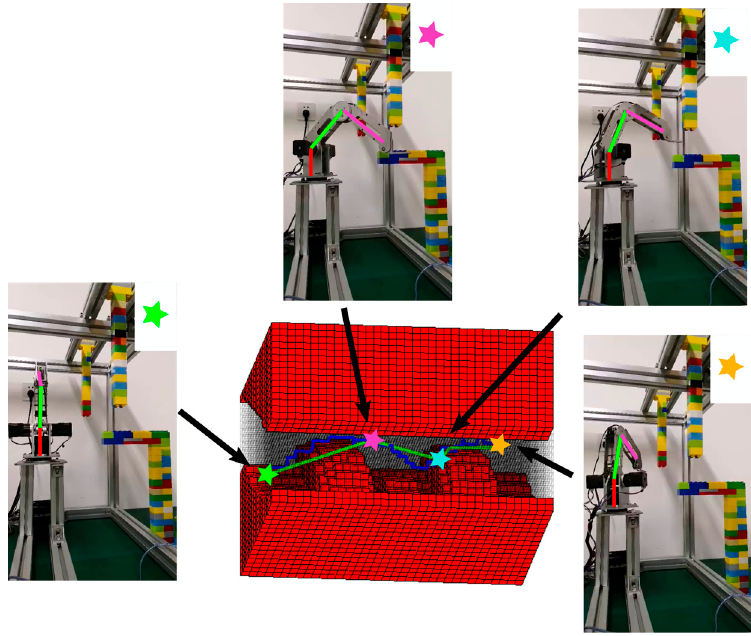
Figure 18. The path generated with the IDCS method (dark blue) and the Opti-IDCS method (green) for the first experiment. The robot poses when it reaches the specified positions are shown as